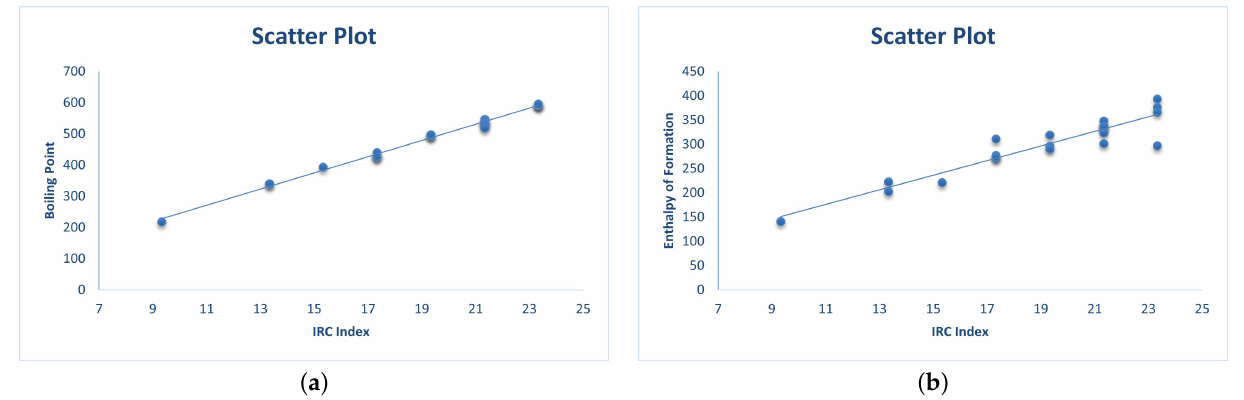
Figure 2. Scatter plots between the IRC index and the two selected properties (i.e., T bp and ∆ H o ( a ) A scatter plot between IRC and T bp . ( b ) A scatter plot between IRC and ∆ H o